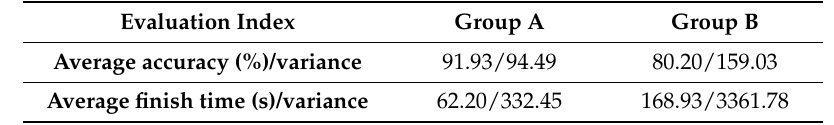
Table 4. Evaluation